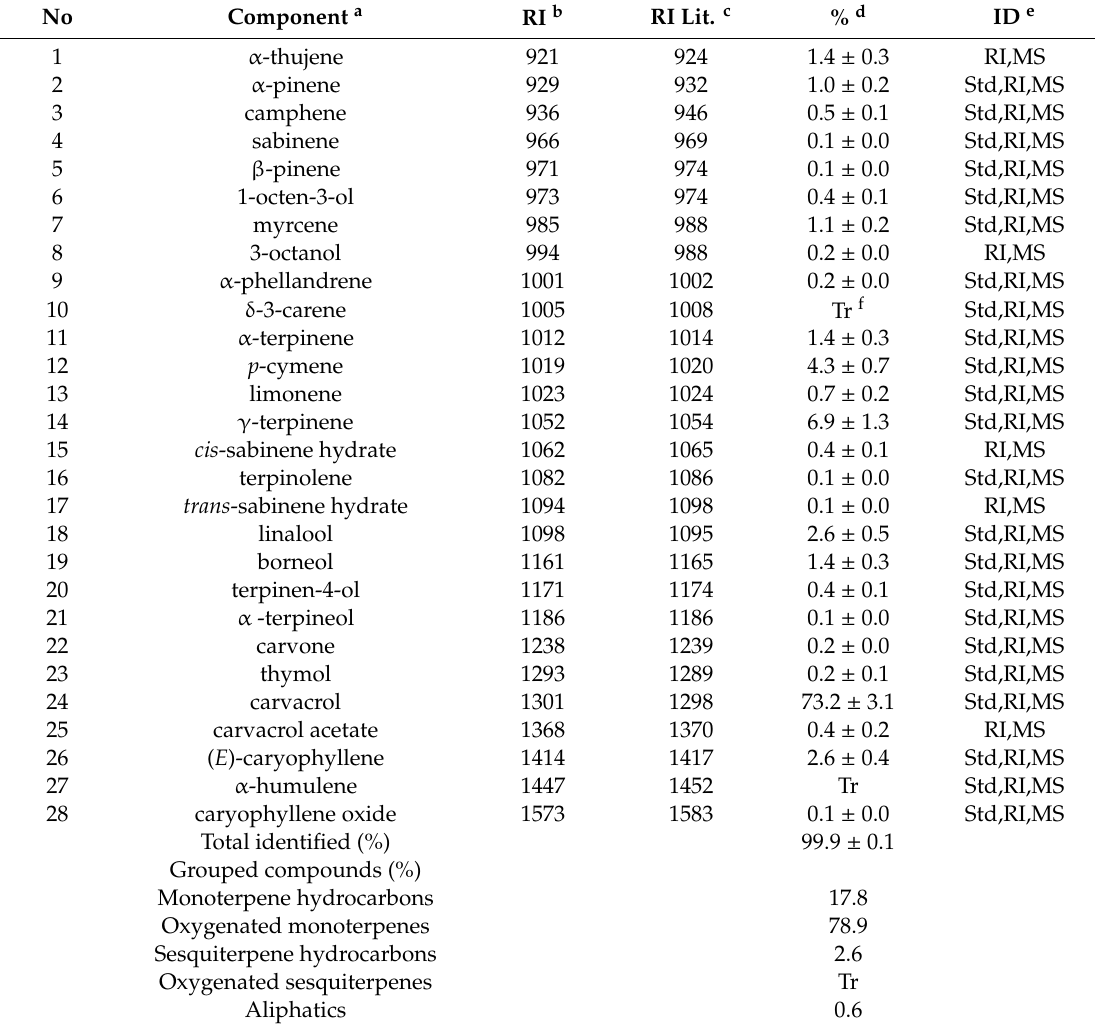
Table 1. Essential oil composition of Thymbra capitata